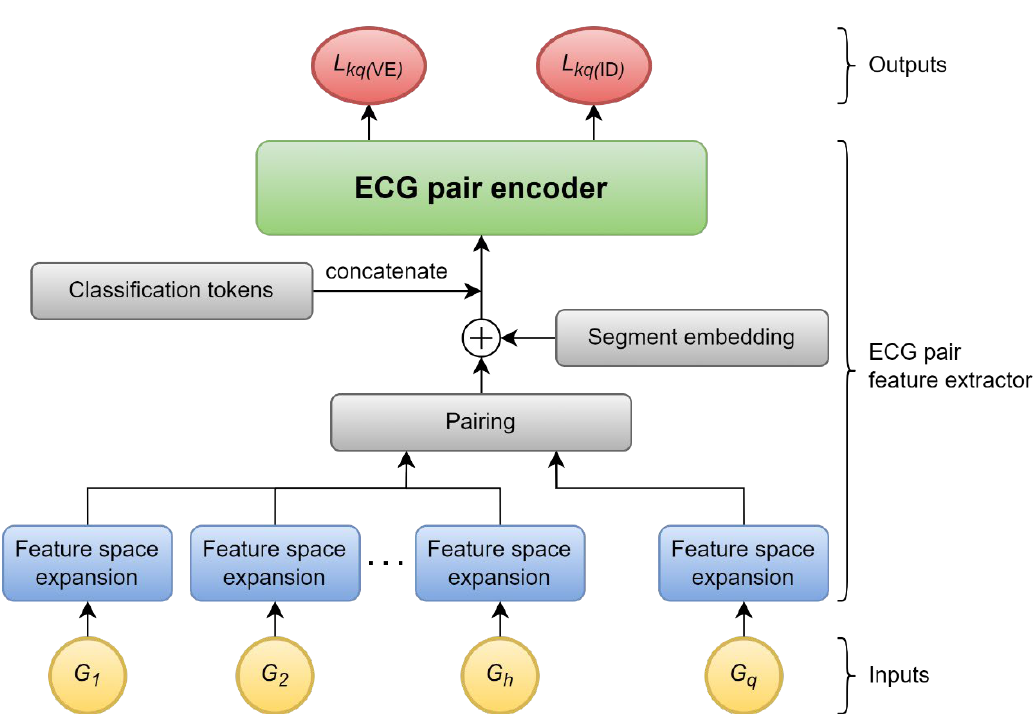
Figure 2. ECG pair feature